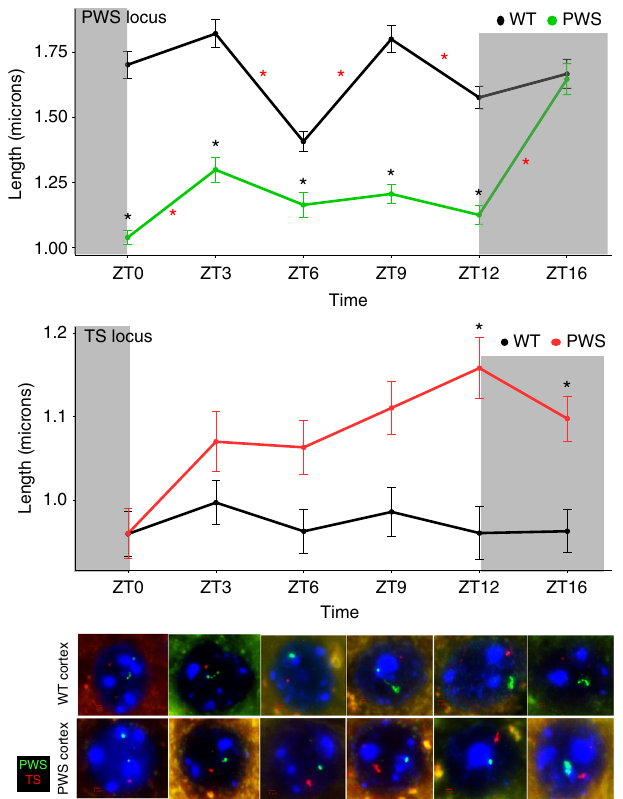
Fig. 7 Snord116 modi fi es chromatin decondensation of both Snord gene clusters in a time-dependent manner. DNA FISH for the diurnal decondensation of the PWS (green) and TS (red) loci, including representative images for each condition. Compact silent alleles of each locus are much smaller and fainter than decondensed active alleles. Exposure was optimized to the bright decondensed alleles and decondensation of the largest allele for each locus was measured. Scale bars represent 1 µ m. Snord116 + / − neurons exhibit light-speci fi c loss of chromatin rhythmicity at the PWS locus and dysregulation of the TS locus. N = 300 nuclei from 3 cortices for each genotype and time point, error bars represent s.e.m. Red asterisks indicate signi fi cance between time points within the genotype and black asterisks indicate signi fi cance between genotypes for a particular time point. Mixed model ANOVA with Tukey correction, see Supplementary Data 11 for full list of p